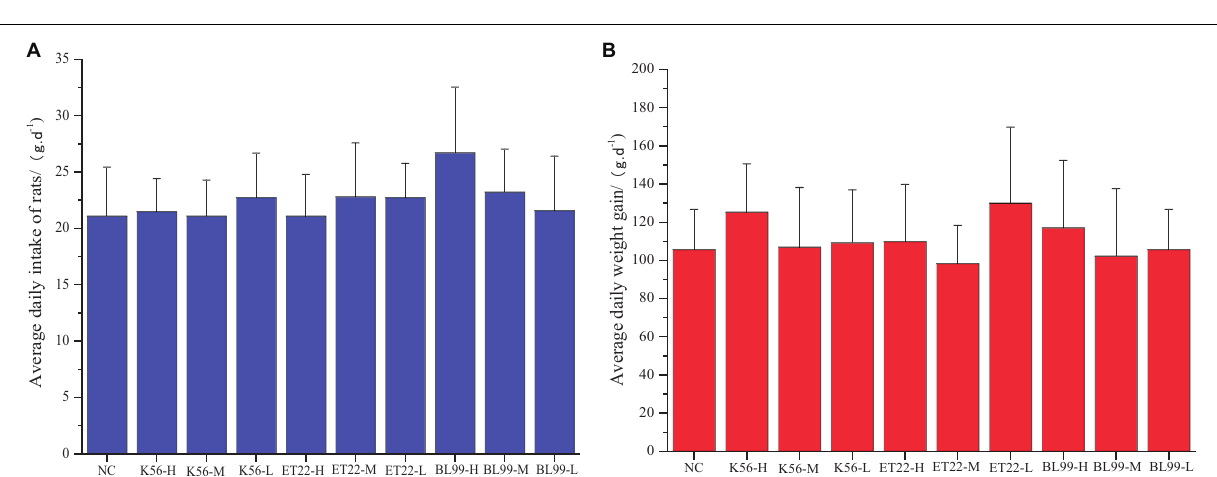
FIGURE 4 | The dynamic change of body weight in ICR mice fed with BL-99, ET-22, and K56 strains within 14 days.